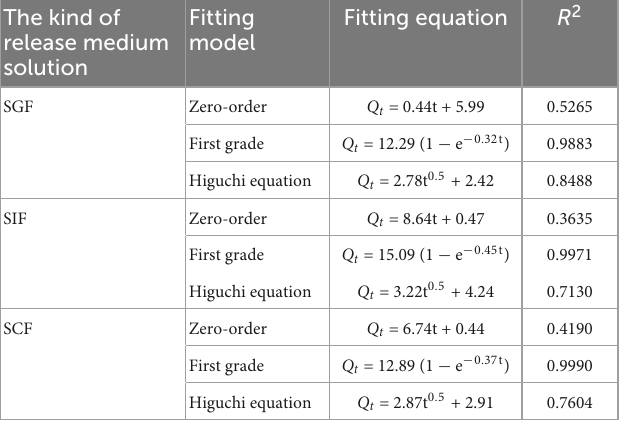
shifted slightly, so the interaction between NG/MSN and KS may be a physical reaction of hydrogen bonding (40), which indicates that KS and NG/MSN are well recombined.